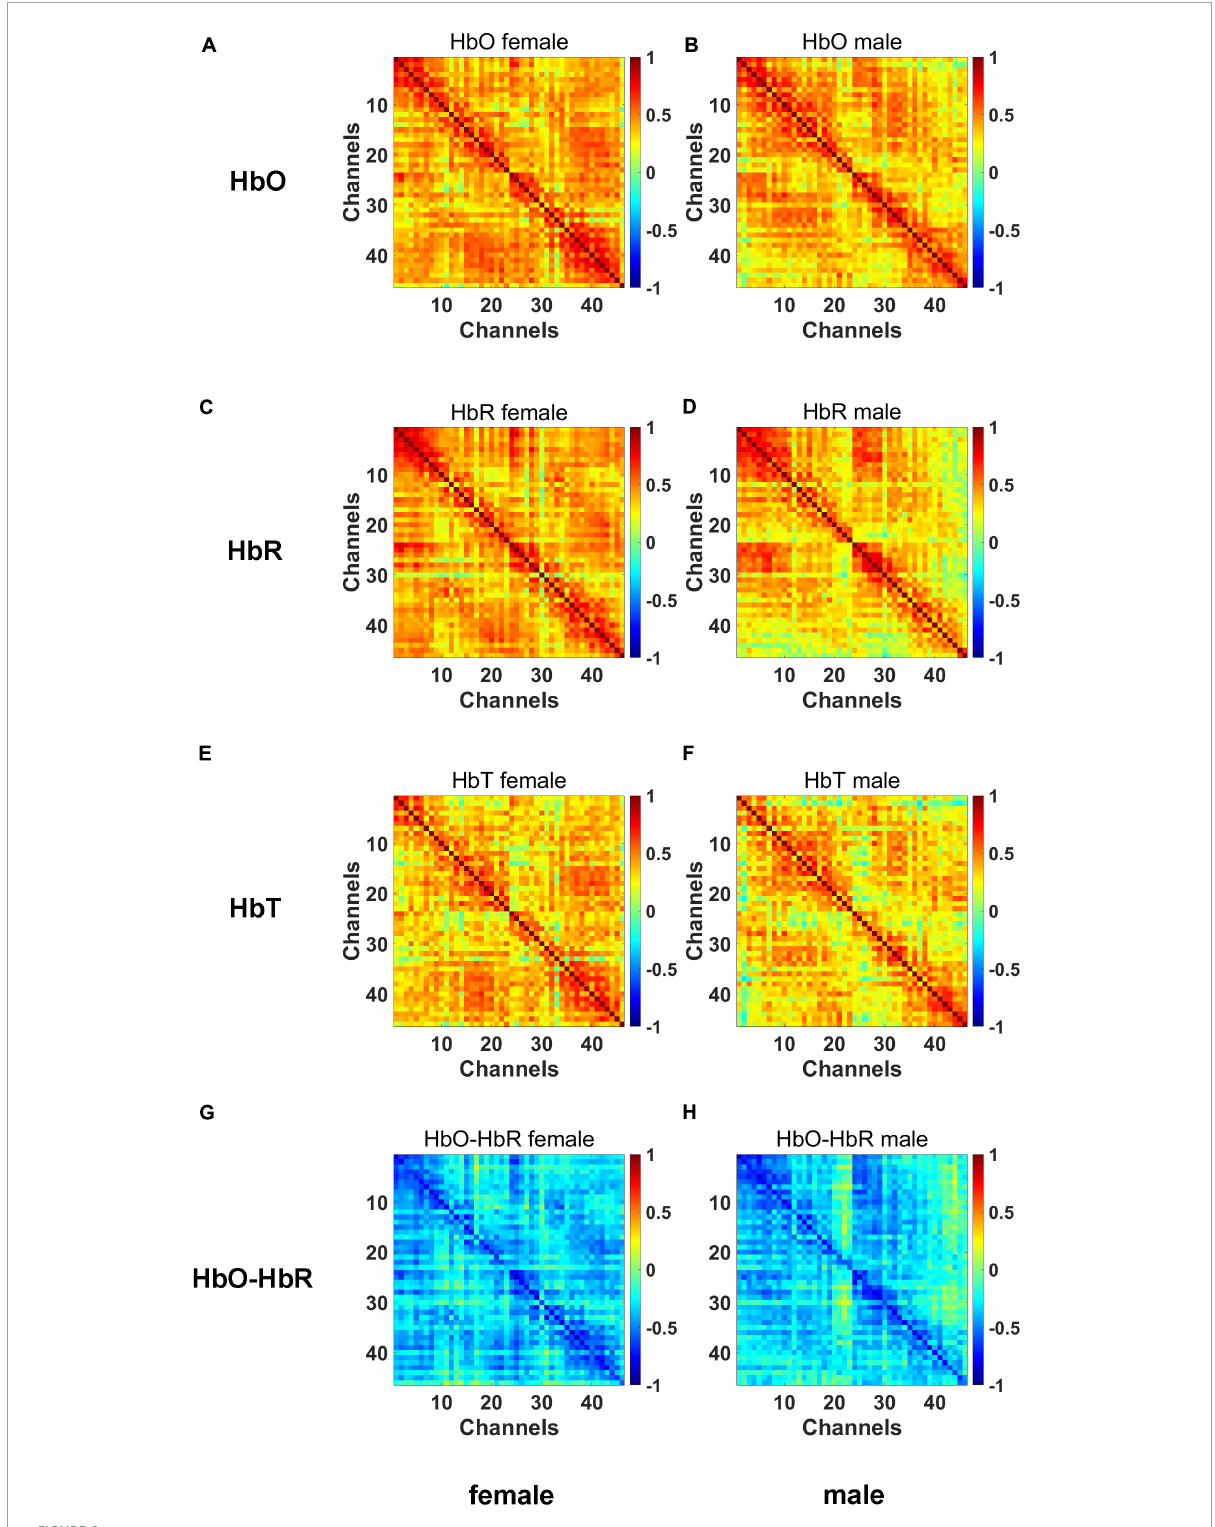
FIGURE6 The adjacency matrices for HbO (A,B) , HbR (C,D) , HbT (E,F) , HbO-HbR (G,H) concentration